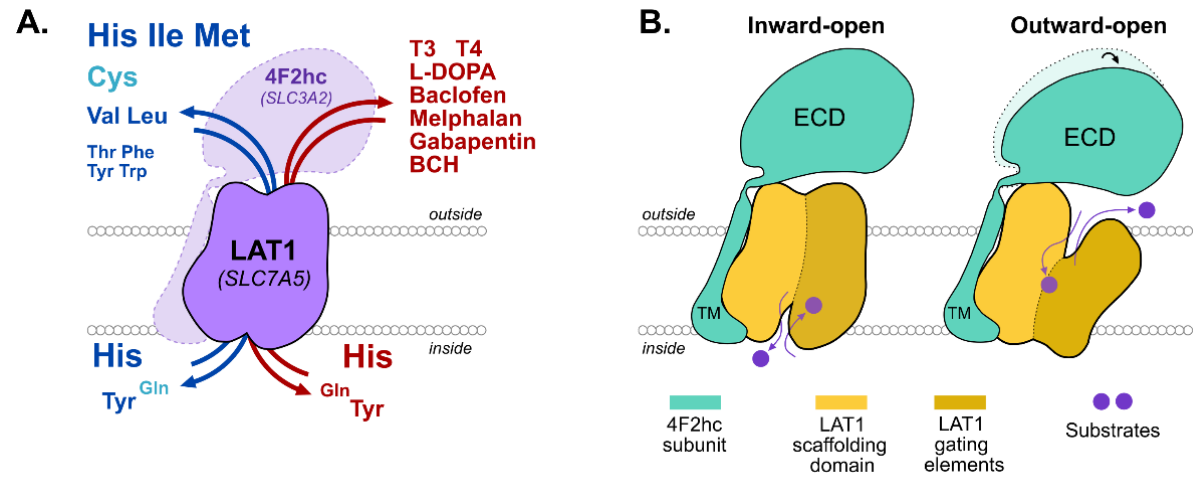
Figure 1. ( A ) LAT1/CD98 (4F2hc) complex schematic structure and its transport function. Blue represents essential amino acids and light blue represents non-essential amino acids (the size indicates the level of specificity of LAT1 to amino acids). The red color represents specificity for non-amino acid substrates (hormones, drugs, inhibitors) [21]. ( B ) LAT1/CD98 (4F2hc) complex working mechanism model. ECD: extracellular domain, TM: transmembrane domain